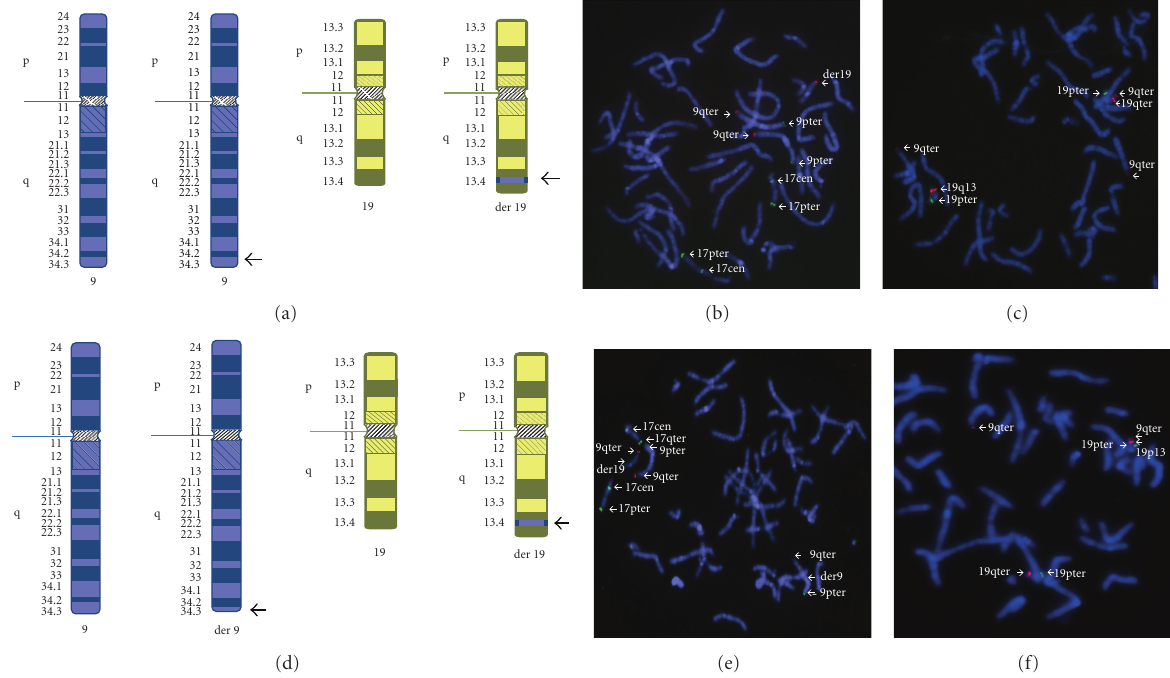
Figure 2: Cytogenetics and FISH analysis of proband and father. ((a)–(c)) and (d-f) show the analysis of the proband and father, respectively. Ideograms of chromosomes 9 and 19 show that part of region 9q34.3 is inserted into region 19q13.4 in the proband (a), and the father is a carrier of a balanced insertional translocation (panel d). FISH analysis used probes for 9pter (305J7-T7), 9qter (D9S325), 19pter (129F16/SP6), 19qter (D19S238E), 19q13 (GLTSCR1/GLTSCR2/CRX), while 17cen and 17q used control probes ((b)–(c) for the proband, and panels (e)–(f) for the father). These panels confirm that the part of region 9q34.3 is inserted into region 19q13.4. The subtelomeres